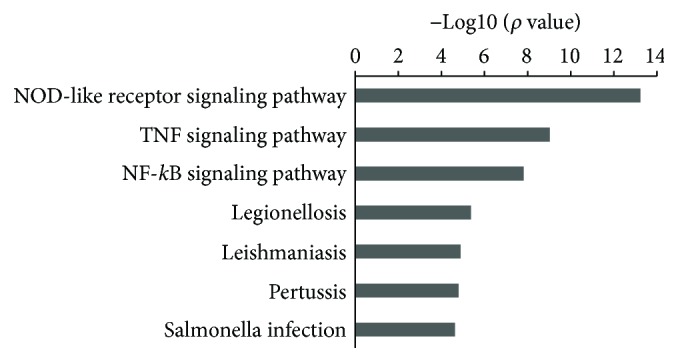
Effects of CBT on the related pathway. The differentially expressed genes of LPS-stimulated human PBMC treated with 40 μg/ml CBT were enriched with DAVID6.8. The black bars showed the pathways in which the differentially expressed gene was found to be involved in the treatment of CBT. The bar plot “−Log10 (P value)” represents the enrichment score of the significant enrichment pathways. And the P value denotes the significance of the correlation between the pathway and the treatment of CBT.